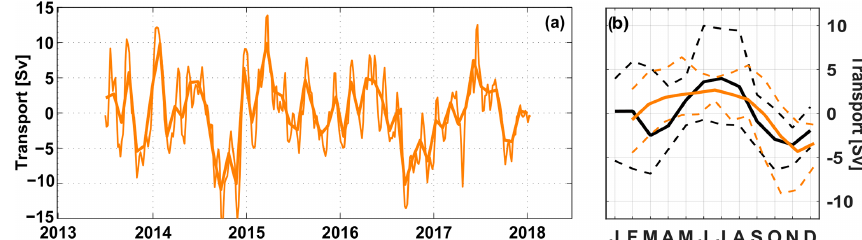
Figure 13. (a) Time series of NBUC transport anomalies (5-daily as thin curve and monthly averages as bold curve) based on moored observations off Brazil (see Sect. 2.4) updated from Schott et al. (2005) and Hummels et al. (2015). (b) Mean seasonal cycles of the NBUC transport anomalies averaged over the periods 2013–2018 (orange curve) and 2000–2004 (black curve). The thin dashed curves show the absolute range of possible minima and maxima per each month for the periods 2013–2018 (orange) and 2000–2004 (black), respectively.